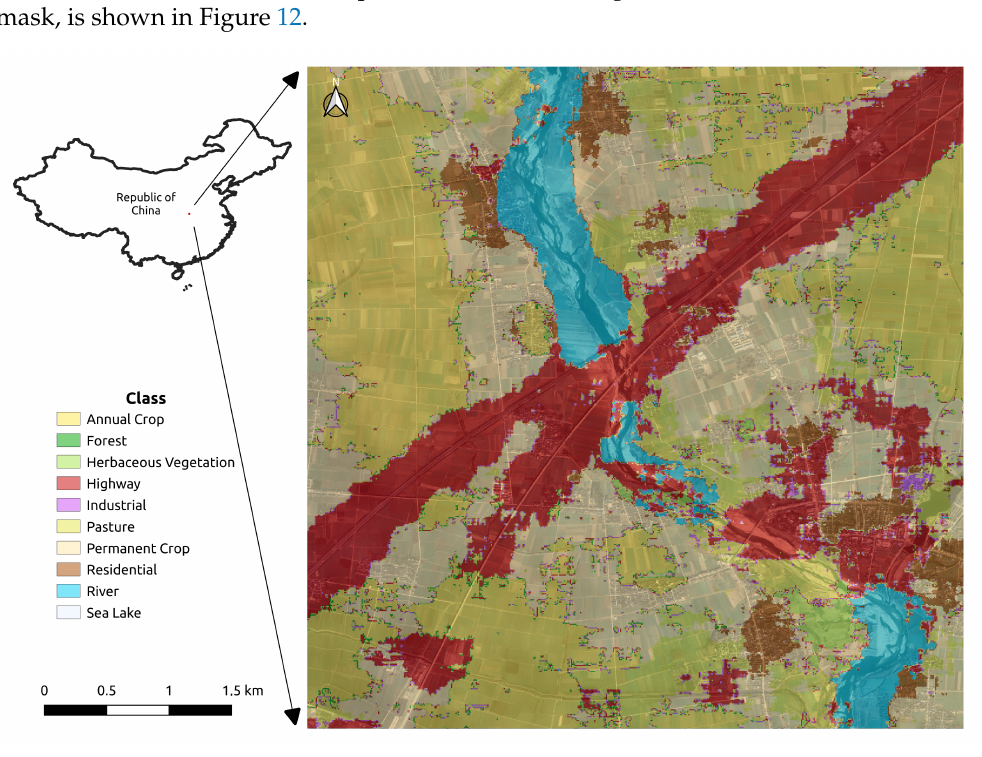
Figure 12. False-Color LC map of a region along the CER, located in Central